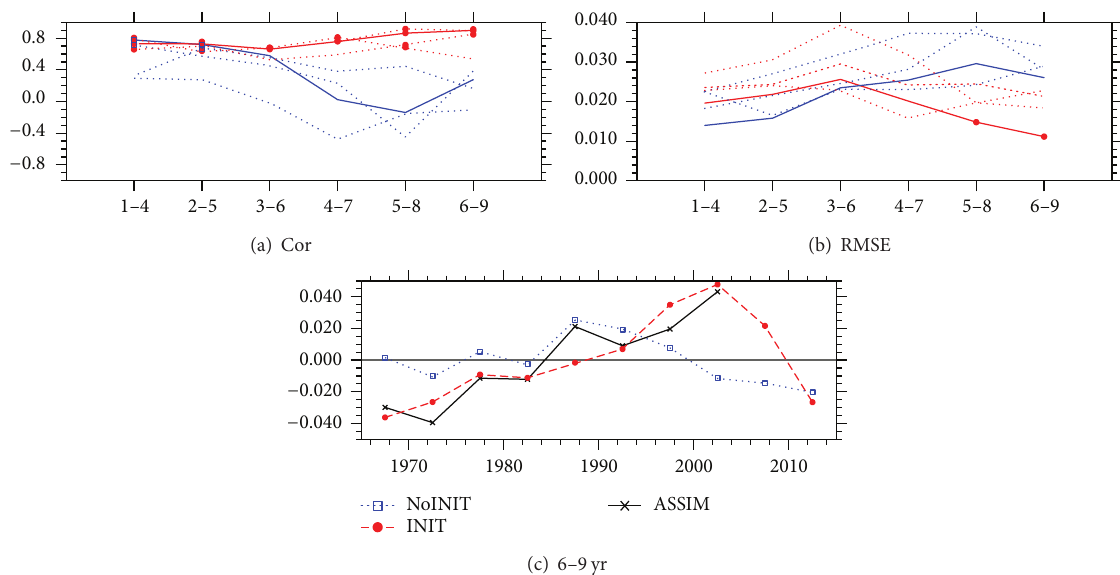
Figure 7: As in Figures 3(a)–3(c), but for the northward oceanic heat transport anomalies in the North Atlantic averaged over 0–40 ∘ N (units: PW). The observation references are replaced by the results from the ASSIM runs.